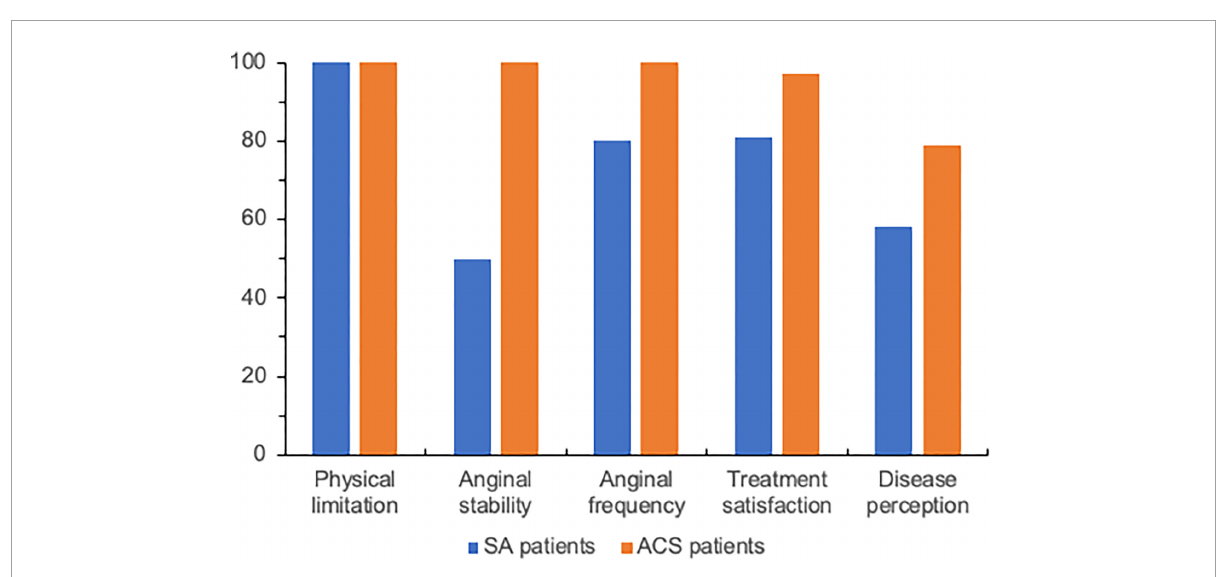
FIGURE1 Median values of Seattle Angina Questionnaire items at 30-month follow-up in patients with stable angina (SA) or non-ST elevation acute coronary syndrome (ACS) but no obstructive coronary artery disease. See Table 3 for details of